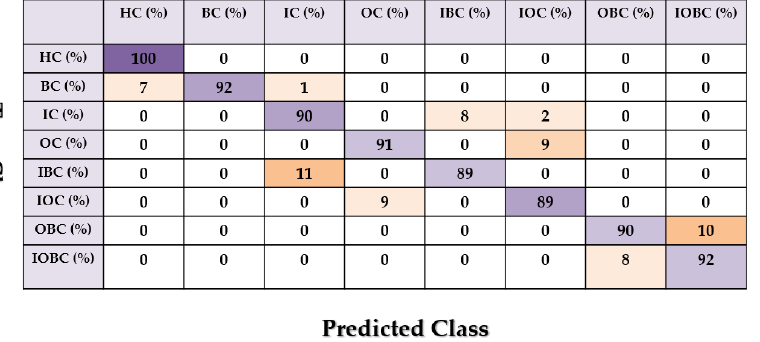
Figure 15. The average of crack type diagnosis using the combination of the PDT and SVM ap- proaches. Based on these figures, the range of misclassification accuracy using the combined PDT and SVM methods was less than that of the other two techniques. Moreover, Table 4 shows the average accuracy of crack diagnosis. Table 4. Average accuracies of crack type diagnosis using the combined ALSGL-SB and SVM, ALSGL-SBI and SVM, and PDT and SVM approaches . Conditions ALSGL-SB and SVM (%)